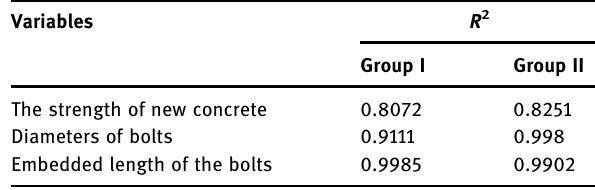
Table 8: Correlation coe ffi cient R 2 for the linear regression